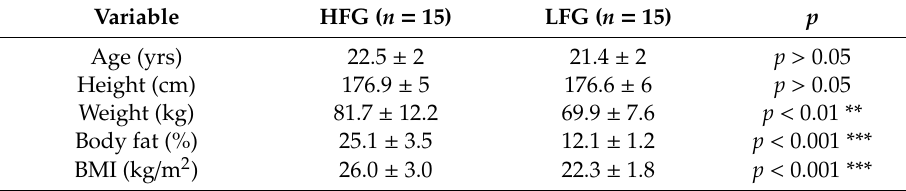
Table 1. Participant characteristics by